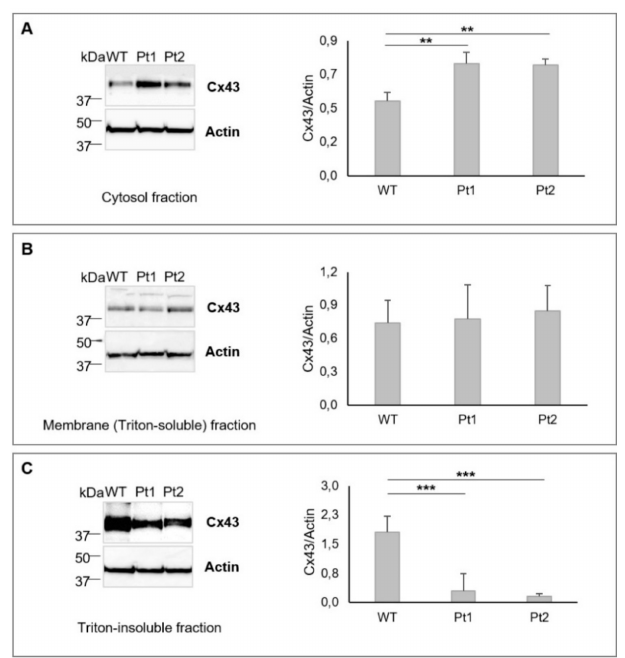
Figure 2. Cx43 protein expression in cytosolic and membrane Triton-soluble and Triton-insoluble fractions of U251 astrocytoma lines overexpressing MLC1: ( A , B ) WB analysis performed on 40 µ g of protein extracts shows that Cx43 is significantly more expressed in the cytosolic compartments of Pt1 and Pt2 mutant cells when compared to WT MLC1 expressing cells ( A ) while no significative di ff erences are observed in the membrane protein (Triton-soluble) extracts ( B ). ( C ) The analysis of Triton-insoluble fraction (60 µ g of protein extracts) reveals significantly higher Cx43 protein levels in WT MLC1 + cells when compared to cells expressing Pt1 and Pt2 mutations. Actin is used as a loading control. Molecular weight markers are indicated on the left (kDa). One representative experiment out of three performed is shown. Densitometric analysis of the Cx43 protein band normalized with the amount of actin is evaluated for each cell fraction. The bar graphs represent means ± SEM of three experiments. Statistical di ff erence was calculated using the Kruskal–Wallis test (** p < 0.01 and *** p < 0.001).